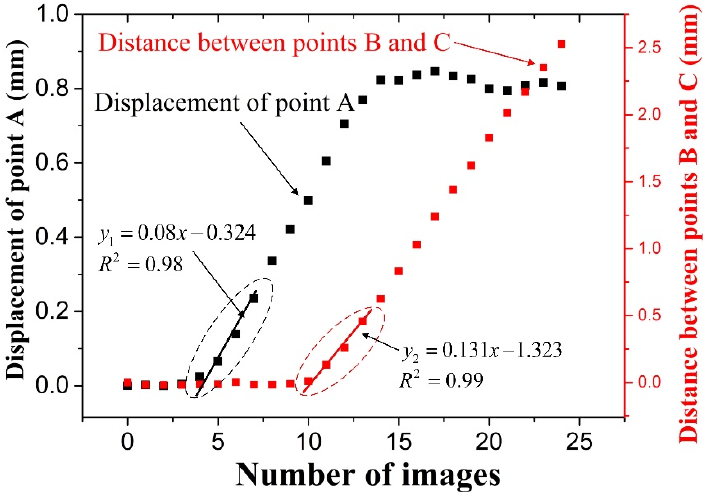
Figure 8. Scatter diagram of displacement change at point A and distance variation between points B and C of the specimen without a turning point in the load–time curve.